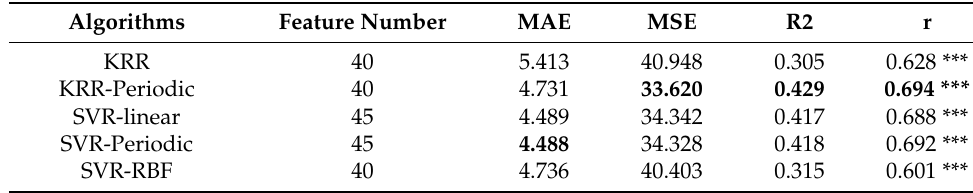
Table 2. Performance comparison of different